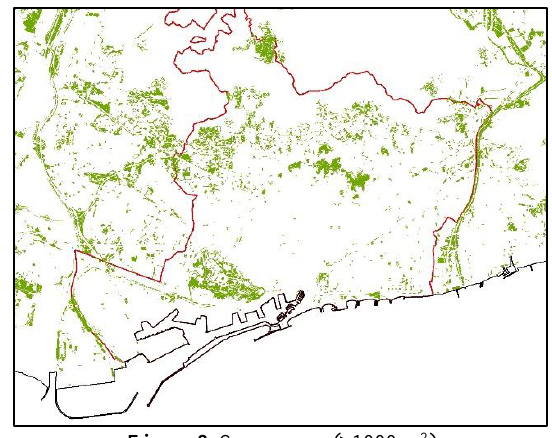
Figure 8. Green areas (>1000 m 2 )